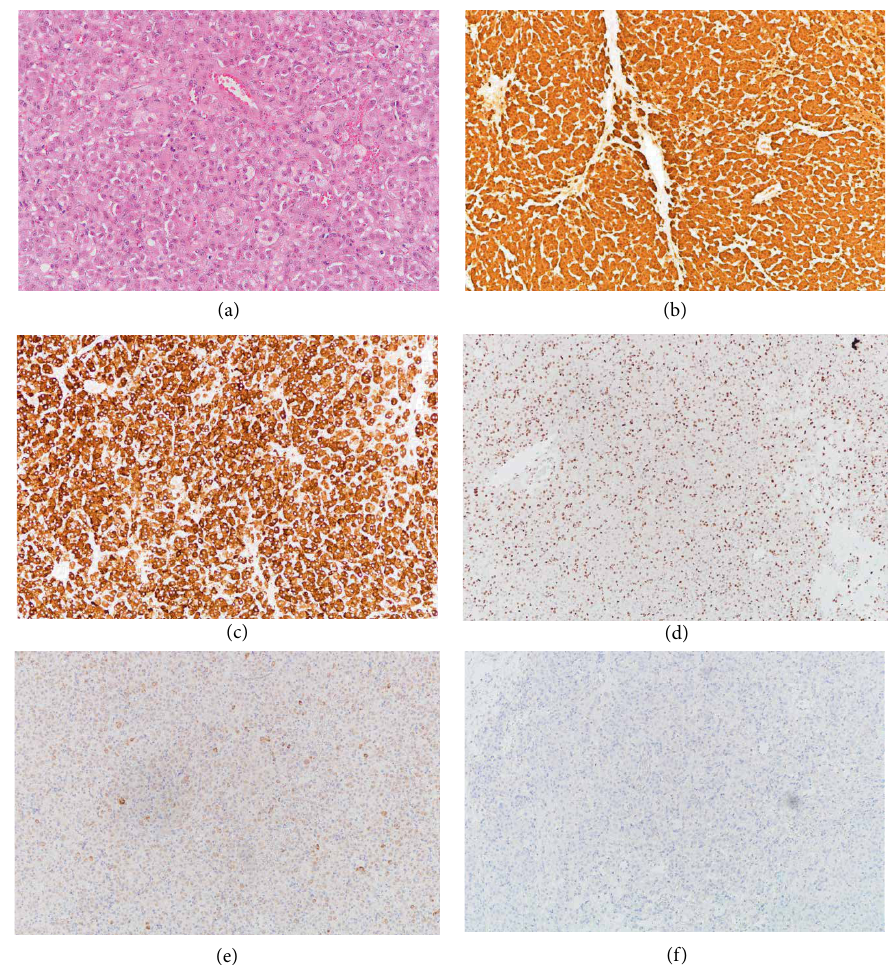
Figure 2: (a) Microscopic appearance of the tumor (20x magnification); (b) Calretinin immunostain (10x magnification): Positive; (c) Inhibin immunostain (10x magnification): Positive; (d) Androgen receptor immunostain (10x magnification): Positive; (e) Melan-A immunostain (10x magnification): Weakly positive; and (f) CD-99 (10x magnification) immunostain: